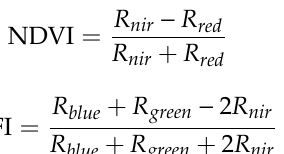
Figure 2. Flow chart of the classification process by using the Classification and Regression Tree (CART) algorithm. Table 1. Interpretation keys of all land cover types.